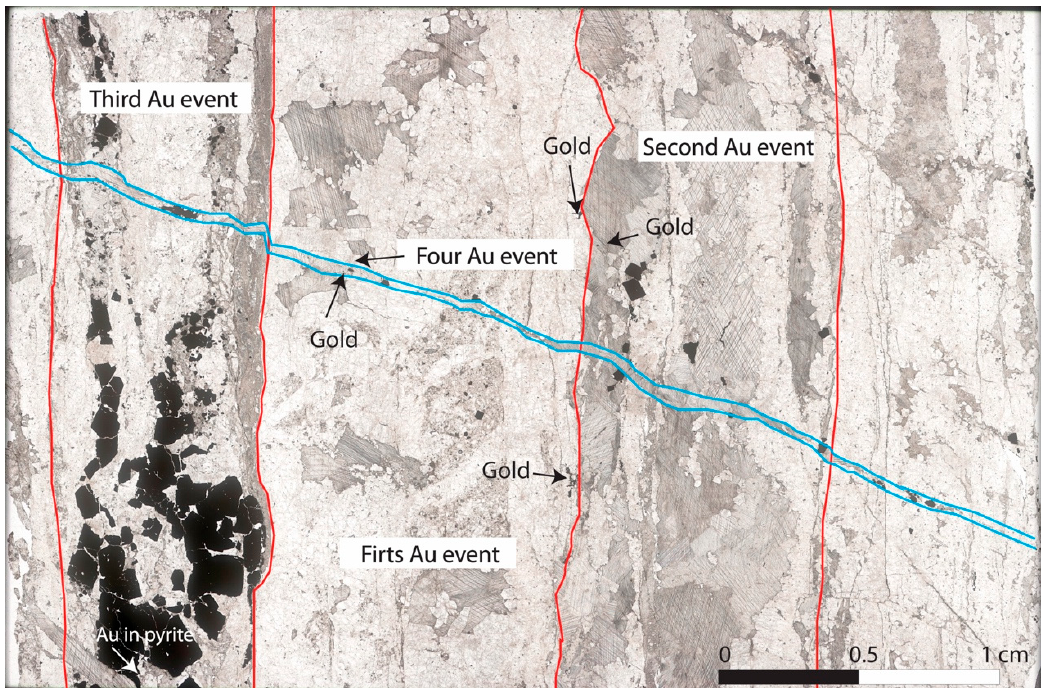
Figure 11. Paragenetic events in the sulfide zone in San Juan de Chorunga vein system (sample SNJ-PET-05).